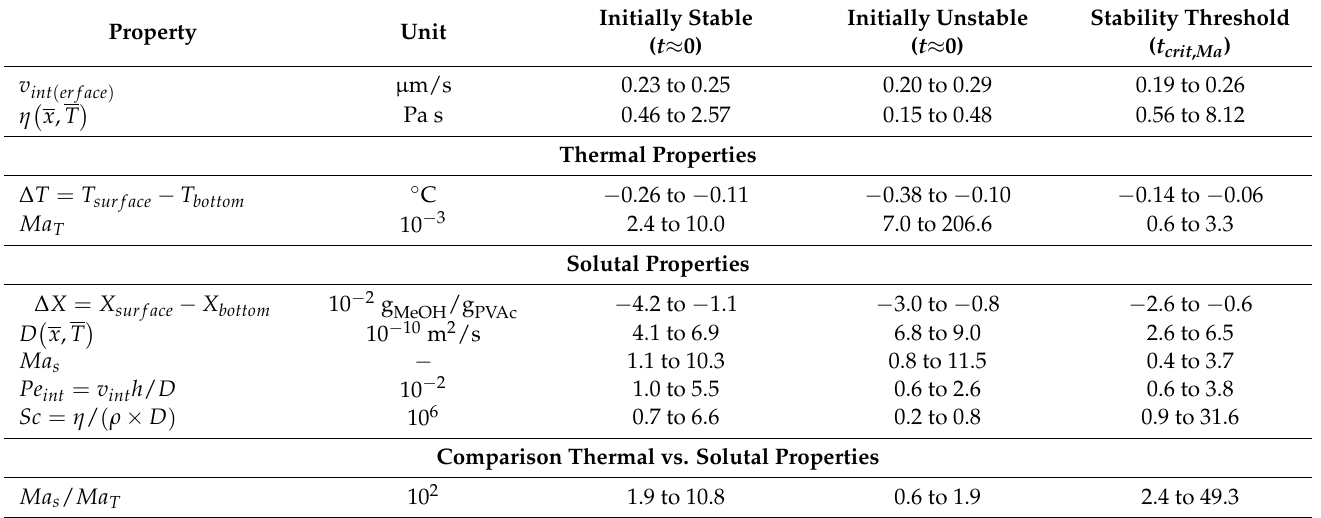
Table 2. Summary of relevant properties regarding Marangoni instabilities calculated from non-isothermal simulations with α bottom = (50 W)/(m 2 K), matched to µ PTV experiments, and from material properties summarized in Section 2.5. The black circles in Figure 10 indicate the source of